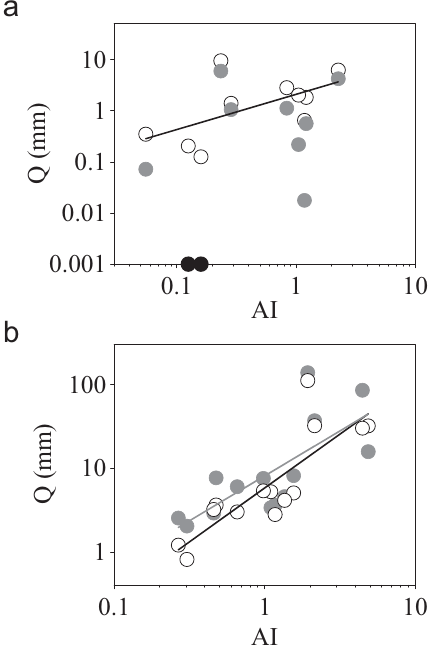
Fig. 2. Relationship between monthly aridity index (AI) and stream runoff ( Q ) at the valley-bottom (grey circles) and hillslope (white circles) catchments during (a) the transition and (b) wet periods. The grey and black lines indicate the power fit between AI and Q for the valley-bottom and hillslope catchments, respectively (only when significant, p < 0 . 01). The black circles correspond to months when the valley-bottom stream ran